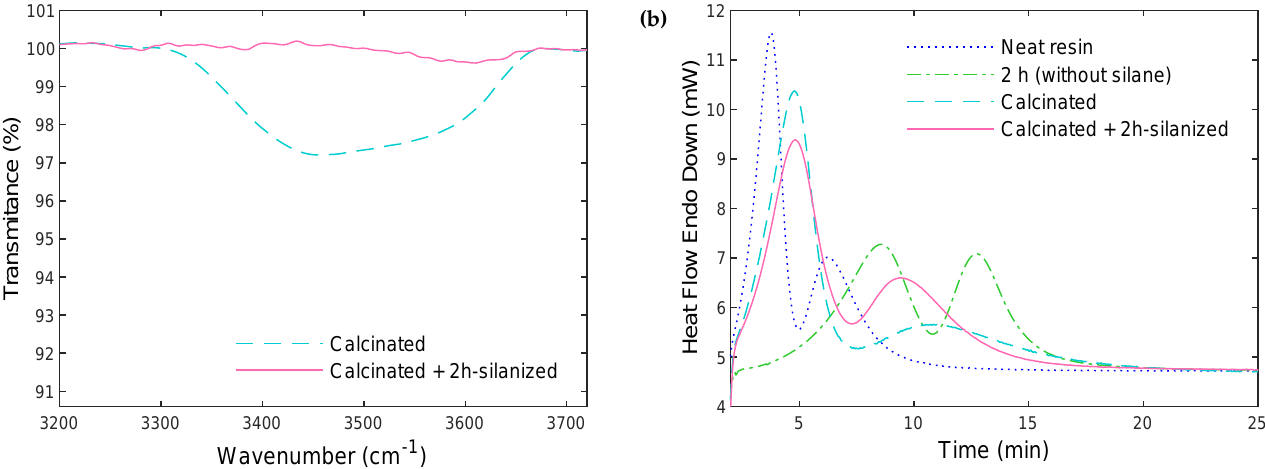
Figure 7. ( a ) FTIR spectra of calcinated particles, and of calcinated + 2 h-silanized particles. ( b ) Poly- merization and crystallization heat flow curves during isothermal synthesis at 180 ◦ C of PA6 and PA6-glass particles composites synthesized with calcinated particles, rehydroxylated particles for 2 h in the silanization solution (without silane) and calcinated + 2 h-silanized particles. For the silanized particles, the mass loss measured by TGA includes both the loss of -OH groups, and the loss of the grafted silane. It is thus possible to deduce the mass loss related only to the -OH groups from Equation (5), which provides the hydroxyl groups’ surface concentration from the transmittance peak. Accordingly, Table 2 shows the total mass loss, hydroxyl mass loss, and silane mass loss, for particles silanized for 2 h, compared to the calcinated particles. The mass loss related to the -OH groups decreases considerably after silanization. These results confirm the successful grafting of the silane agent on the surface of the